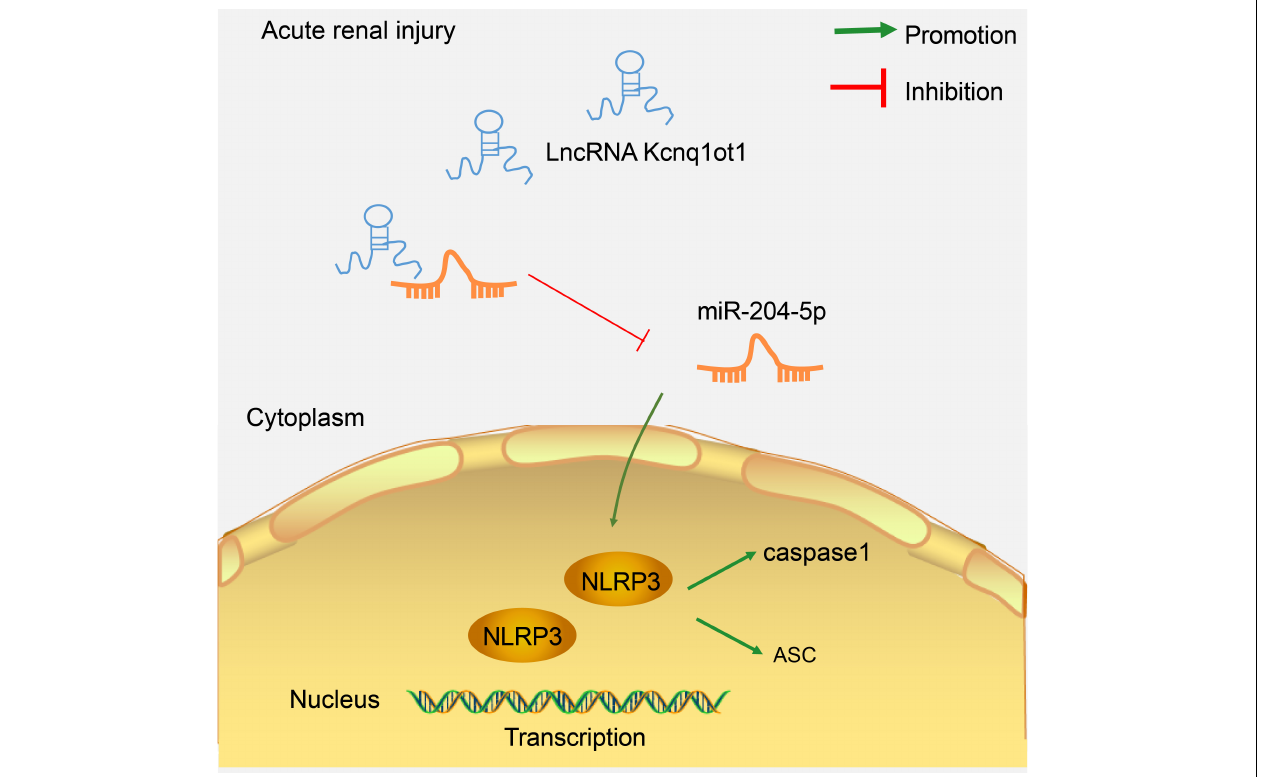
FIGURE 7 | LncRNA Kcnq1ot1 mediated NLRP3 inflammasome activation by sponging miR-204-5p as ceRNA. The knockdown of lncRNA Kcnq1ot1 could inhibit NLRP3 inflammasome activation and thus inhibit the inflammatory response in AKI by blocking the sponging of miR-204-5p as ceRNA to increase miR-204-5p